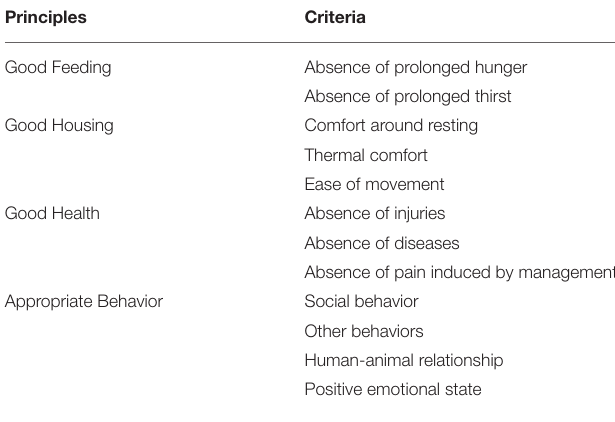
TABLE 1 | Principles and criteria defined in the European Welfare Quality project to assess animal welfare